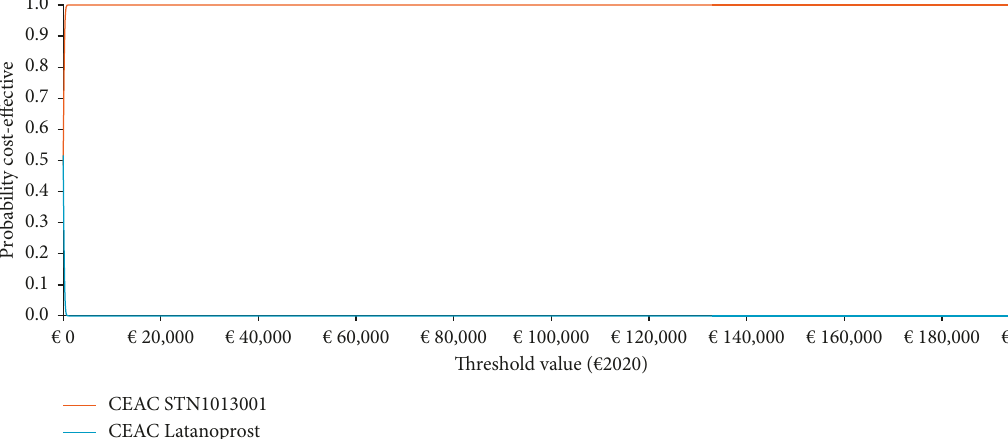
Figure 5: Probabilistic sensitivity analysis-II-cost-effectiveness acceptability curve (1000 out of 1000 threshold values reported) (